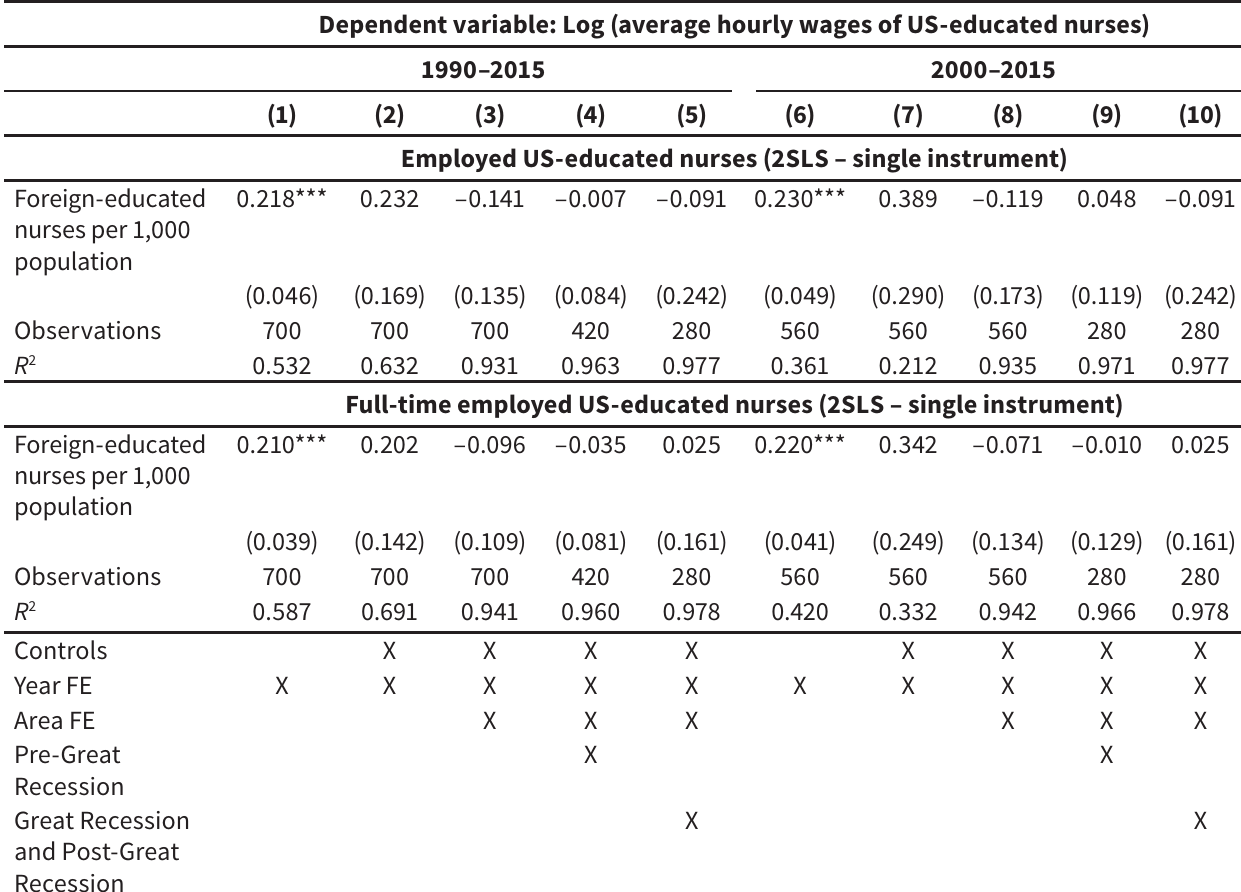
Wage effects of foreign-educated RNs on US-educated RNs Dependent variable: Log (average hourly wages of US-educated